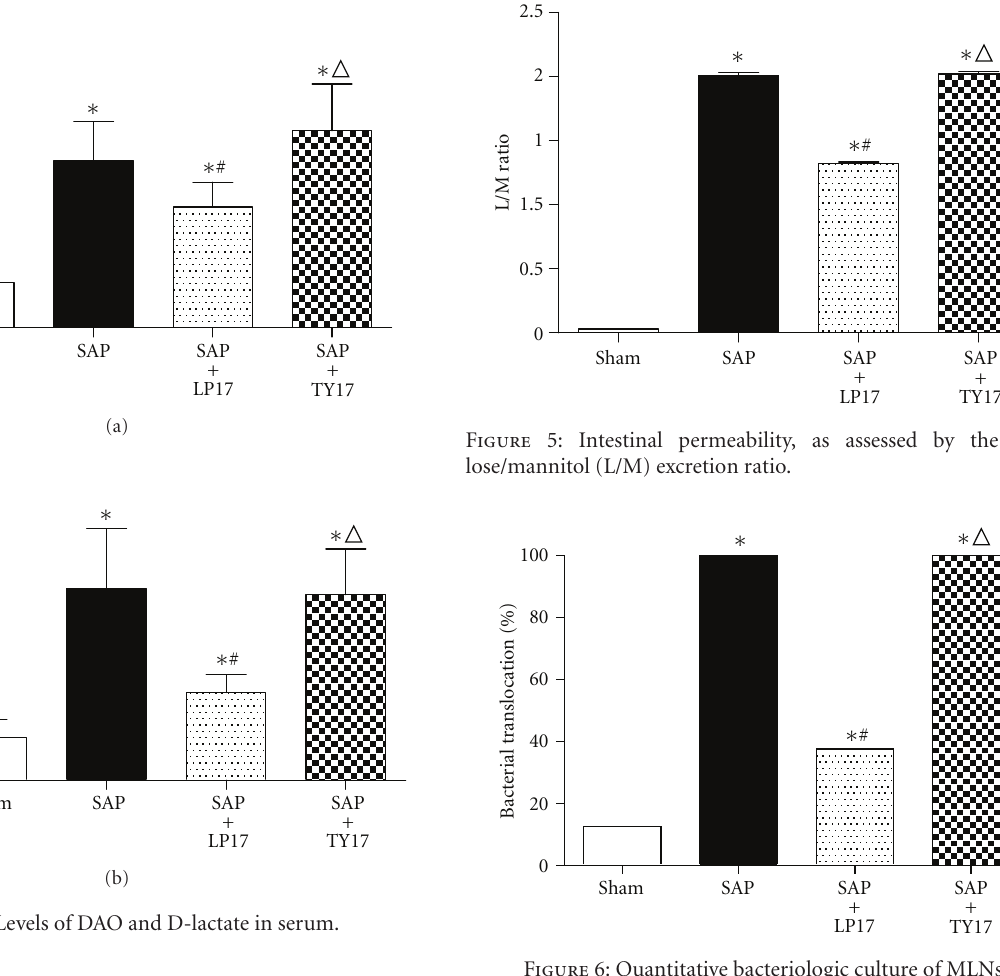
Figure 6: Quantitative bacteriologic culture of